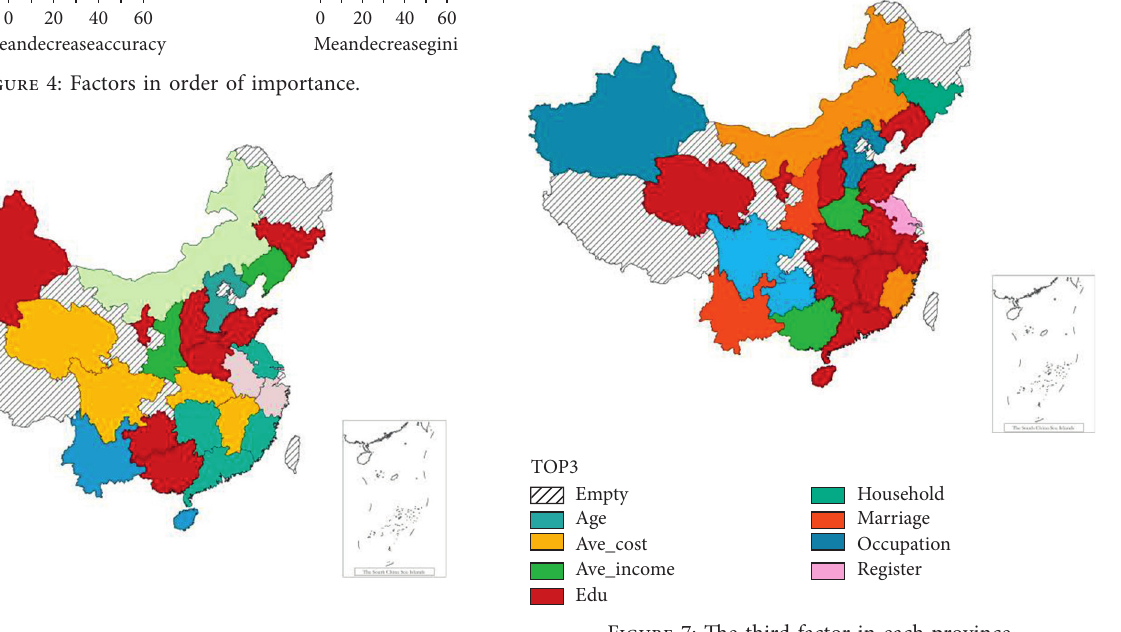
Figure 7: The third factor in each